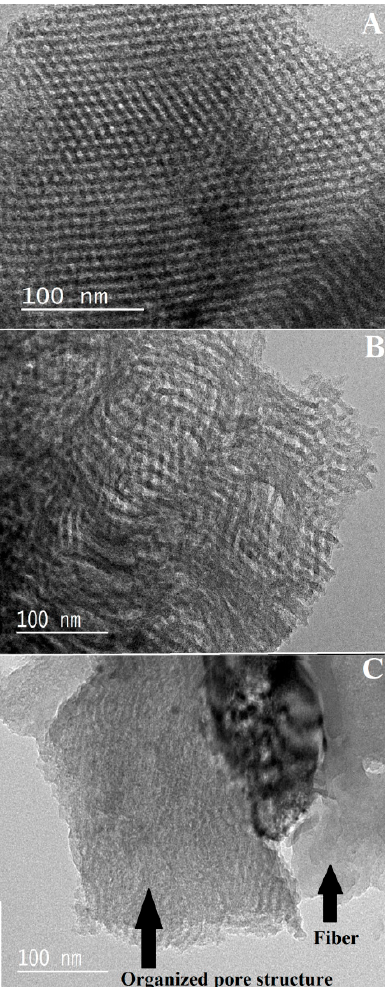
Figure 3. TEM pictures: ( A ) PhR; ( B ) PhR/NC-1 and ( C ) PhR/NC-2